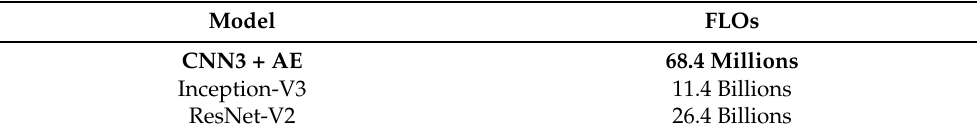
Table 4. Floating point operations for the different models. The smallest number is